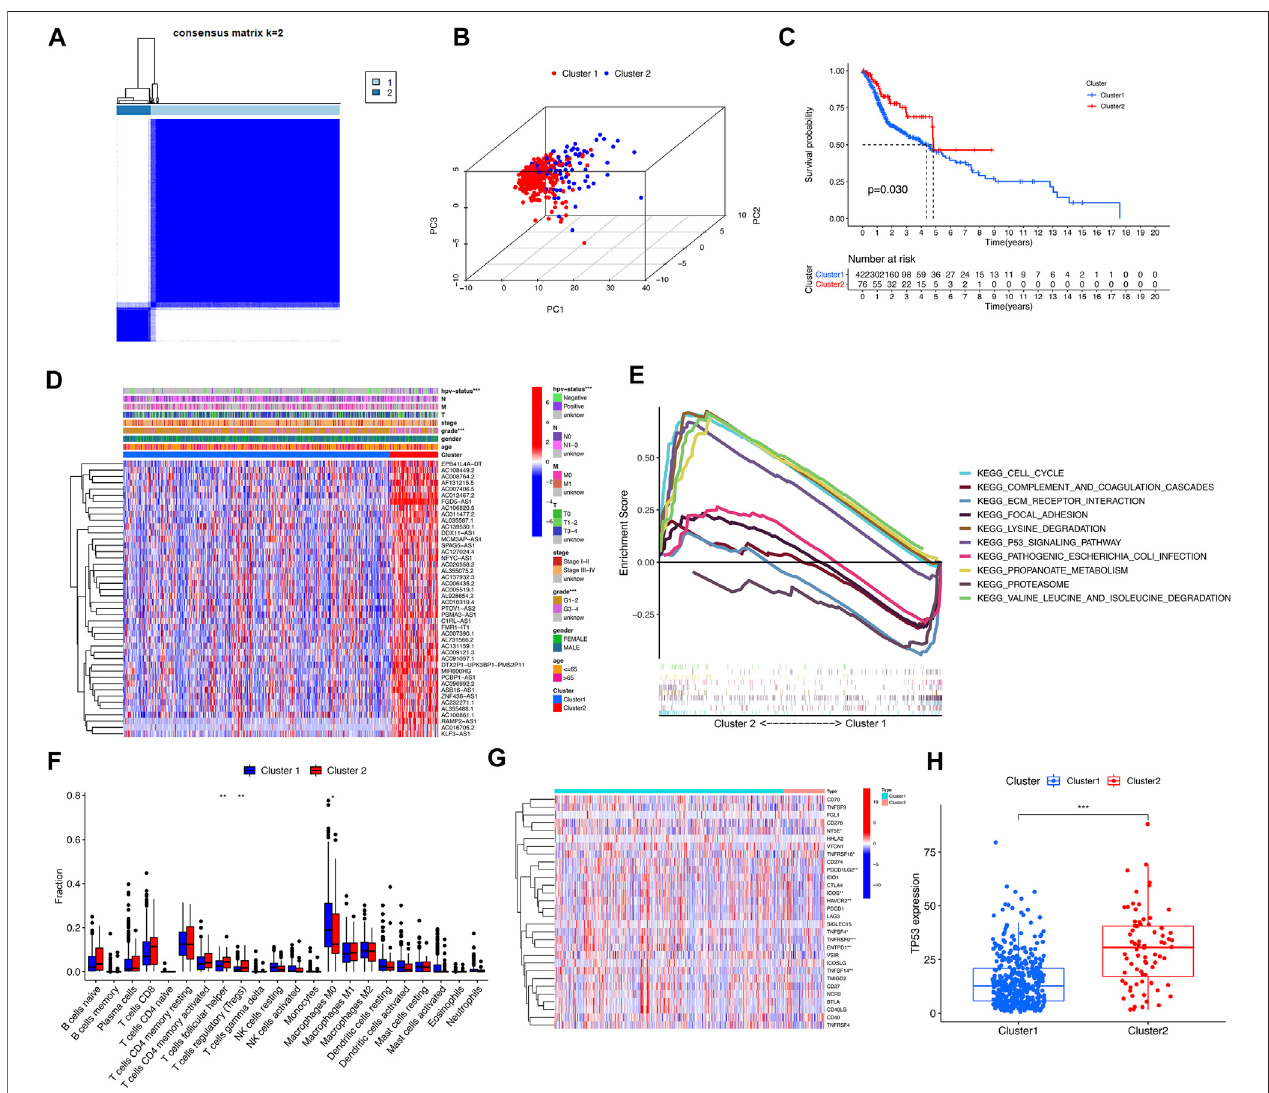
FIGURE3| ClinicalcharacteristicsandoverallsurvivalamongdifferentsubgroupsofHNSCC.*,**,***represent p < 0.05, p < 0.01and p < 0.0001,respectively. (A) Consensusmatrixforoptimalk (cid:1) 2. (B) Principalcomponentanalysis(PCA)ofcluster1andcluster2. (C) Kaplan-Meiercurveofoverallsurvival(OS)timeinCluster1and Cluster 2 ( p (cid:1) 0.03). (D) Heatmap of the clinical features of the two clusters. (E) GSEA analysis displayed key pathways in in Cluster 1 and Cluster 2. (F) The violet plot showed the differential expression of immune cells between Cluster 1 and Cluster 2, in which Cluster 1 was represented in blue and Cluster 2 was represented in red. (G) The heatmap of the differential expression levels of 29 immune checkpoint genes between Cluster 1 and Cluster 2. (H) The boxplot of TP53 expression level between Cluster 1 and Cluster 2.